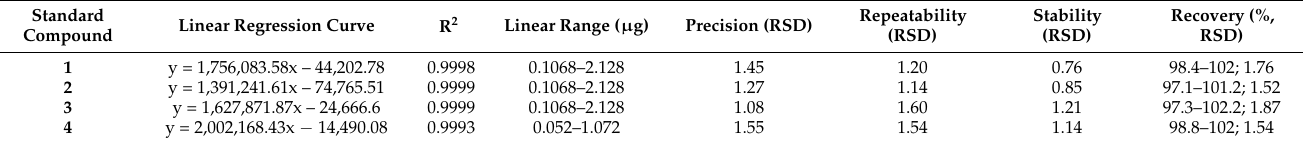
Table 5. Method validation for standard compounds 1 – 4